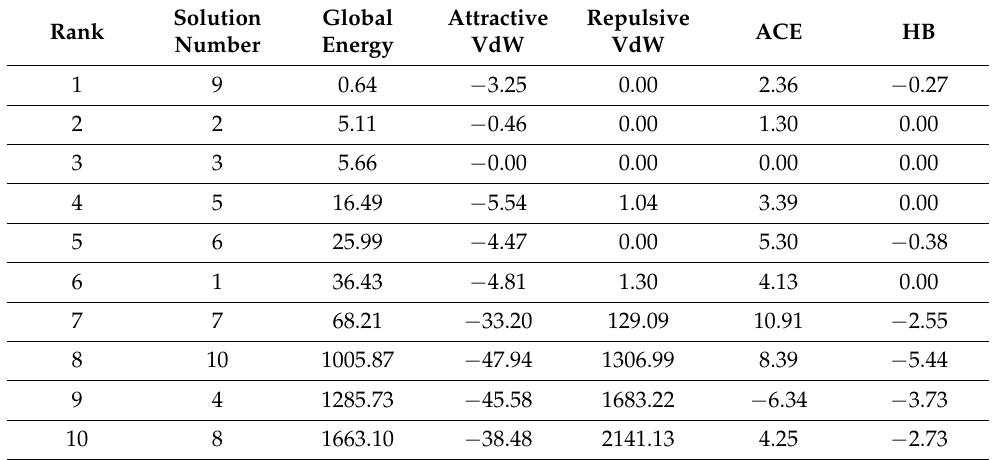
Table 6. Top 10 refined complexes of vaccine and MHC-II molecule. vdW (van der Waals energy), ACE (atomic contact energy), and HB (hydrogen bond energy).